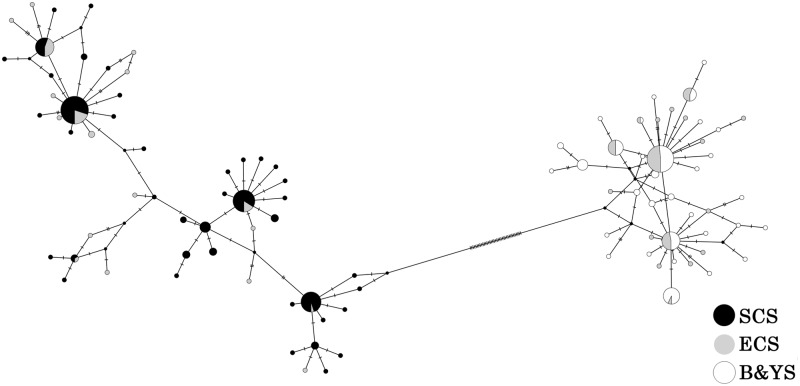
Network of M. petechialis using COI data.The pie charts refer to the haplotypes. B&YS: Bohai and Yellow Sea; ECS: East China Sea; SCS: South China Sea.